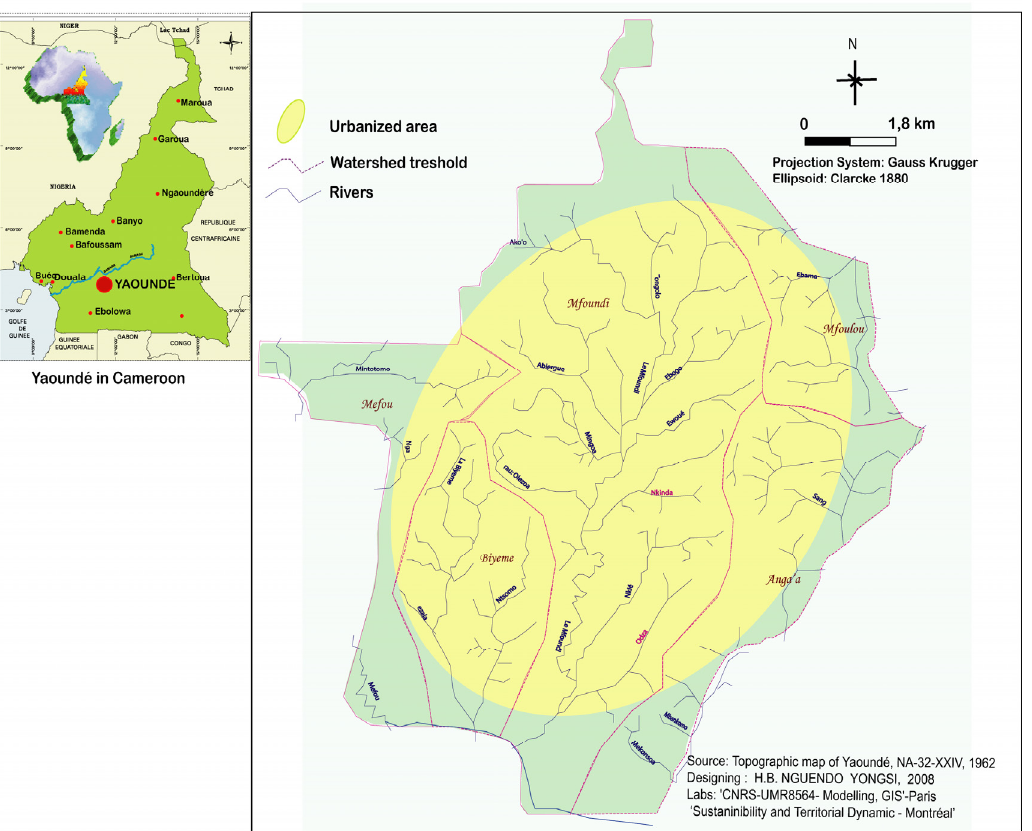
Figure 1. Location of Yaoundé,